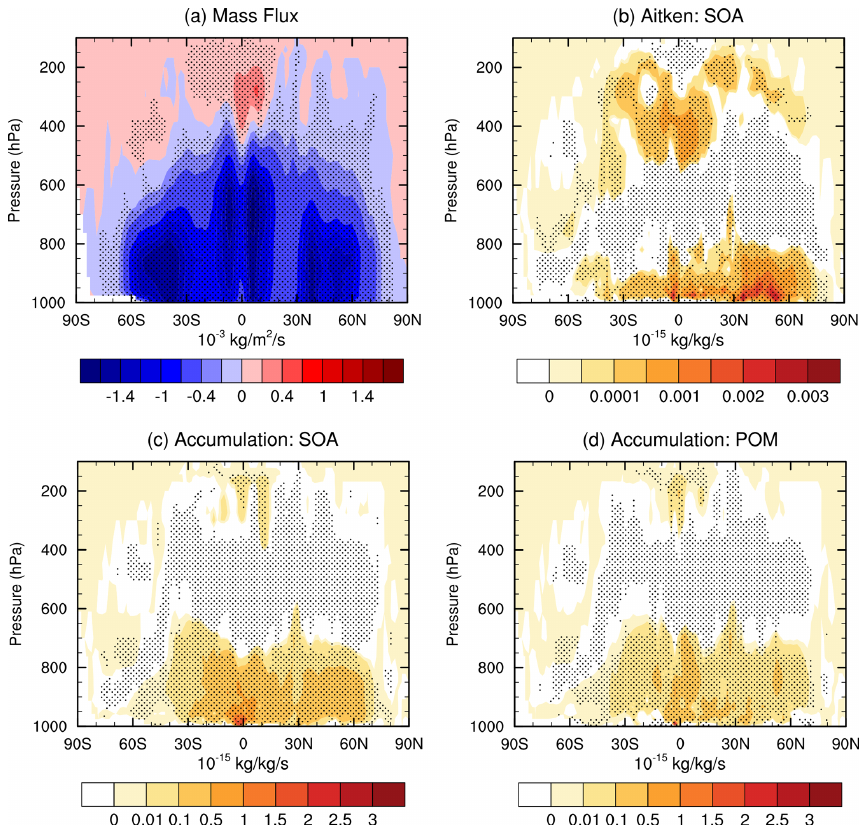
Figure 14. Annual and zonal mean cross sections of changes in (a) mass flux from deep convection and (b–c) vertical transport of POM and SOA aerosols by deep convection between STOC and CAM5 runs (STOC–CAM5). Areas exceeding the 95% t -test confidence level are